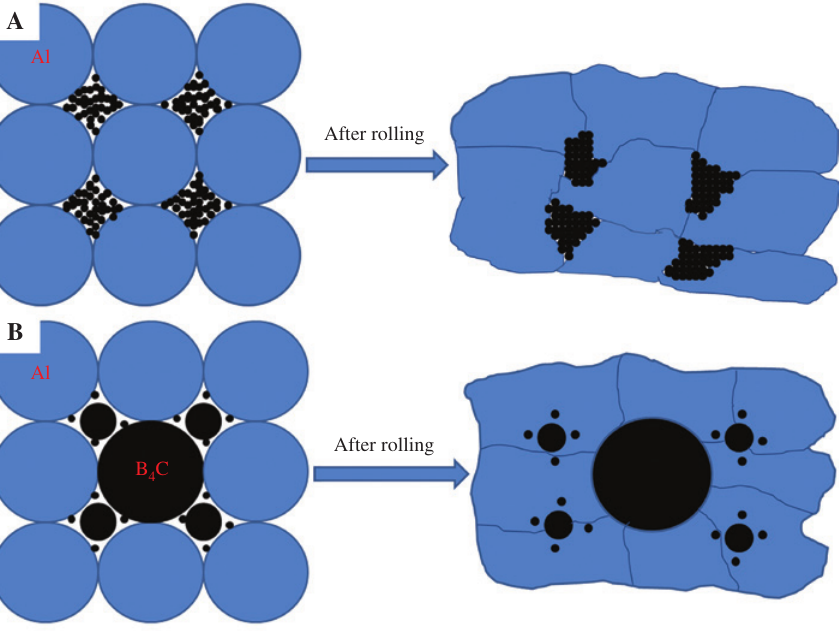
Figure 1: The particle filling model: (A) under conventional conditions, (B) according to the Horsfield filling principle.